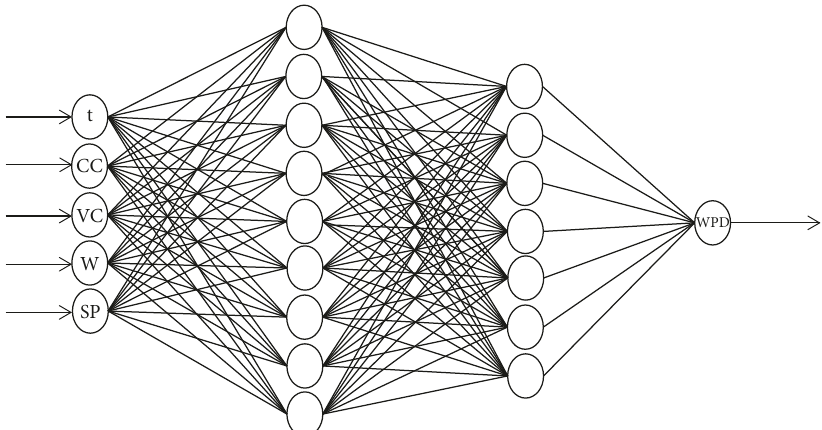
Figure 5: ANN2 model for predicting the water permeability of VS-based